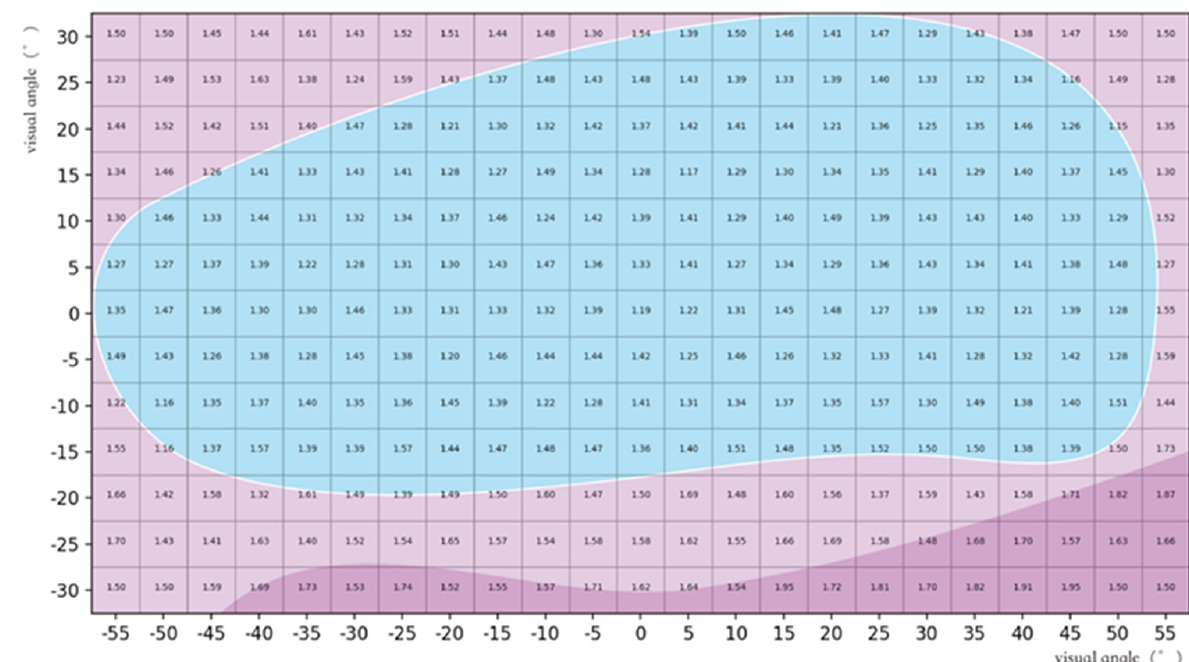
Figure 6. Heat map of click accuracy.